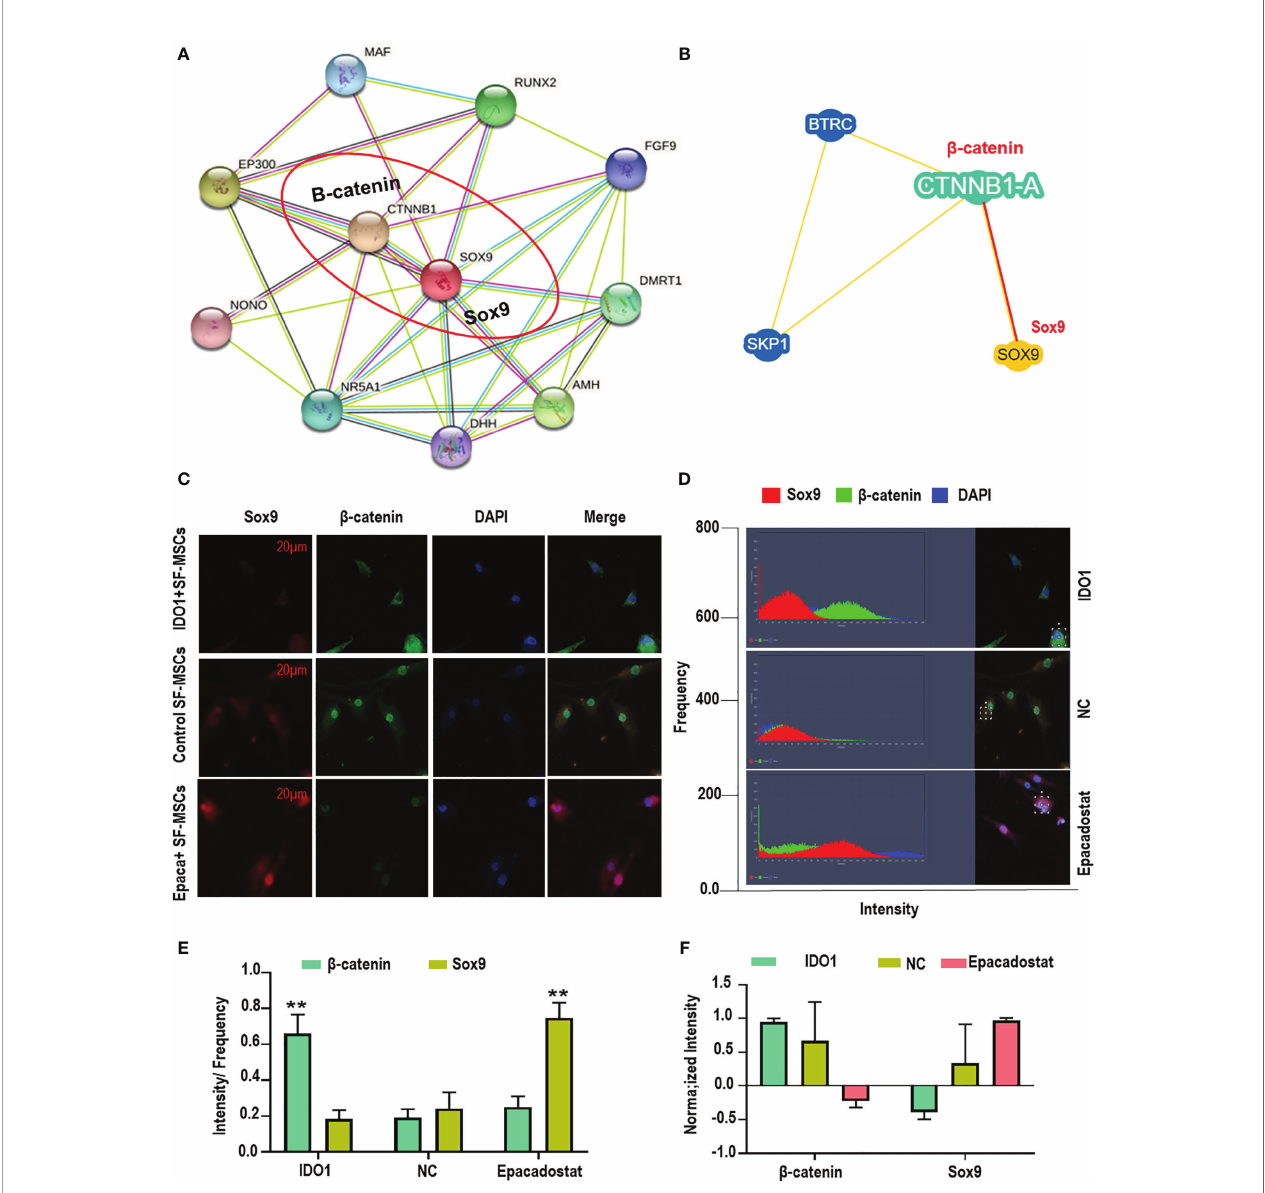
FIGURE 5 | IDO1 induces the anti-localization interaction between b -catenin and Sox9 in the MSCs. (A, B) Bioinformatic analysis of P-P interaction between b - catenin and Sox9 using the database of String-db.org and thebiogrid.org. (C) Colocalization assay between b -catenin and Sox9 using immuno fl uorescence overlapping. (D) The analysis of expression intensity. (E) The calculation of intensity by frequency of every protein expression. (F) The normalizing intensity by calculating Pearson correlation. ** p < 0.01 Epacadostat vs